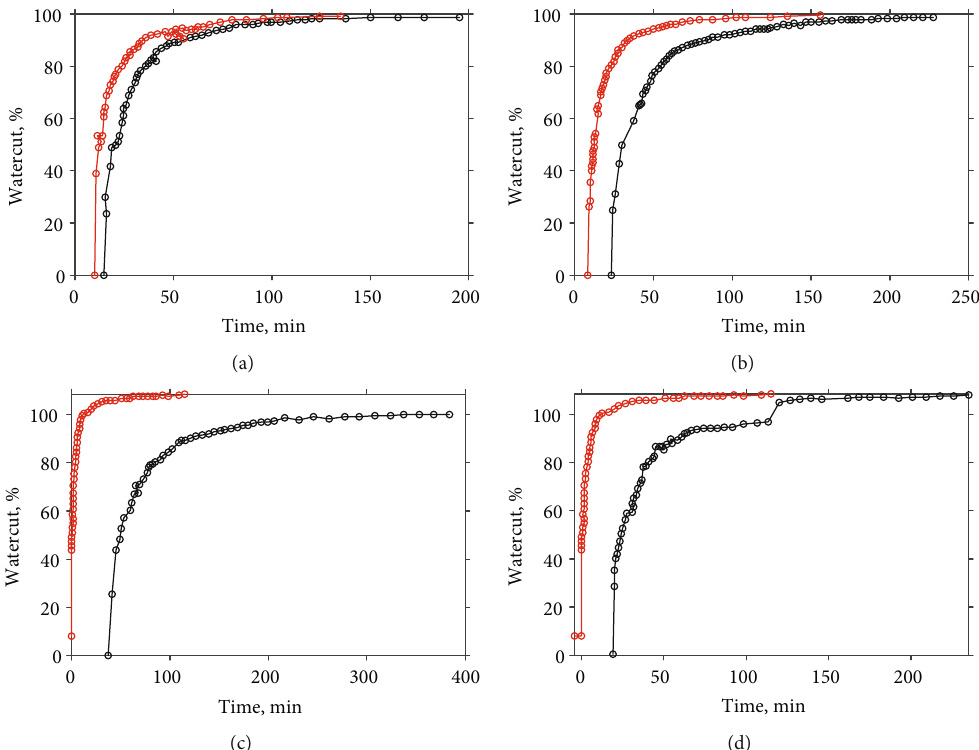
Figure 8: Water content with respect to the water fl ooding time before and after the construction of fracture in the experimental core. The red and black points represent the results before and after the construction of fracture. (a) Cores H1-5. (b) Cores H11. (c) Cores H13. (d) Cores